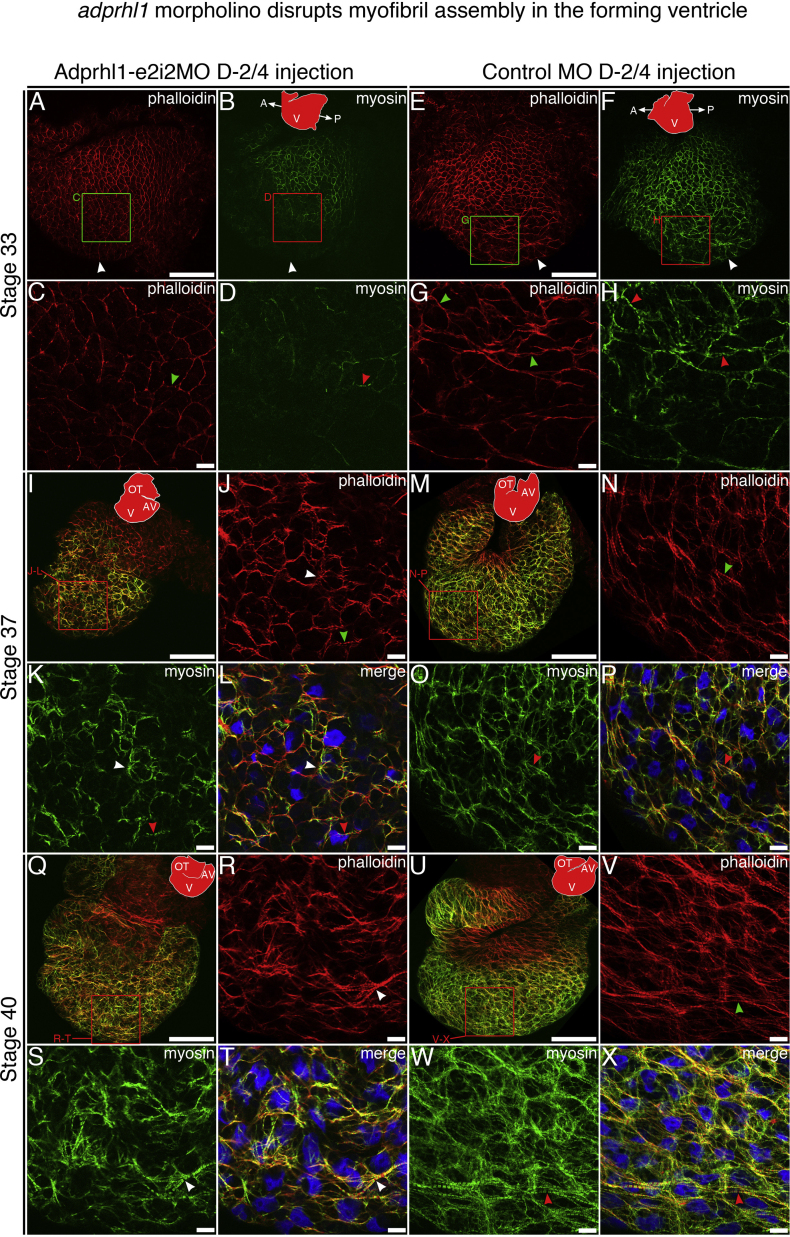
Adprhl1 morpholino disrupts myofibril assembly in the forming ventricle. A–D, I–L, Q–T: Dissected hearts from tadpoles injected with Adprhl1-e2i2MO into D-2/4 blastomeres and analyzed at stage 33 (A–D), stage 37 (I–L) and stage 40 (Q–T). E–H, M–P, U–X: Hearts after control morpholino injection into D-2/4 blastomeres. Phalloidin stain of actin filaments (red) and immunocytochemistry for myosin heavy chain (green) are presented. A-H: At the onset of cardiac looping, stage 33, left lateral view of heart tubes (A, B, E, F). Squares denote the position of 105 µm images (C, D, G, H) in the presumptive ventricle region (apex-white arrowheads). Knockdown of adprhl1 prevents the rearrangement of cortical actin and delays myosin production in the ventricle, thus inhibiting formation of striated myofibrils (coloured arrowheads). Additionally, elongation of cardiomyocytes located near the apex fails to occur. I–P: During ventricle outgrowth, stage 37 hearts (I, M) oriented with anterior surface upwards, showing myofibril patterns in the ventricle wall (J–L, N–P). Myofibrils that eventually form after adprhl1 knockdown are disarrayed (white arrowheads) whereas control myofibrils near the apex extend in a perpendicular direction (coloured arrowheads). Q–X: At stage 40, comparable series of hearts (Q, U) and ventricle images (R–T, V–X). Despite increased synthesis, no recovery of myofibril order and direction occurs with the adprhl1 morpholino. Arrowheads mark equivalent sarcomere positions in the paired panels. Scale bars=100 µm (A, E, I, M, Q, U). Scale bars=10 µm (all others).